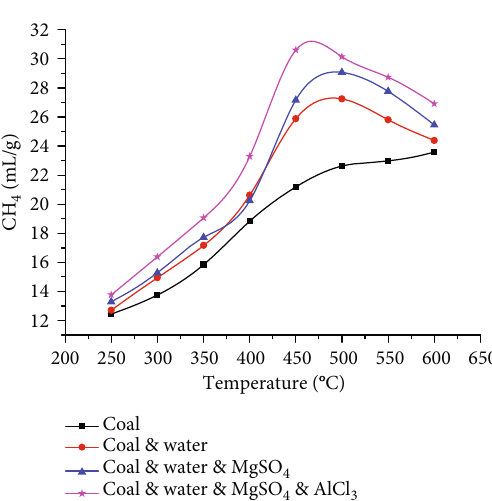
Figure 3: Variation characteristics of total gas.